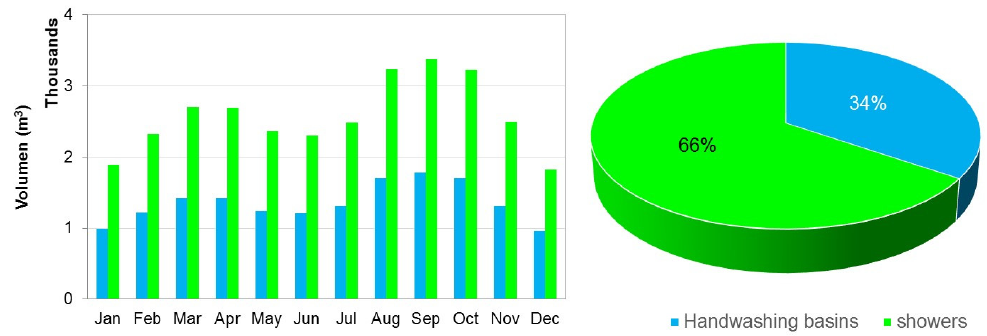
Figure 3. Greywater generation of Monterrey Campus.